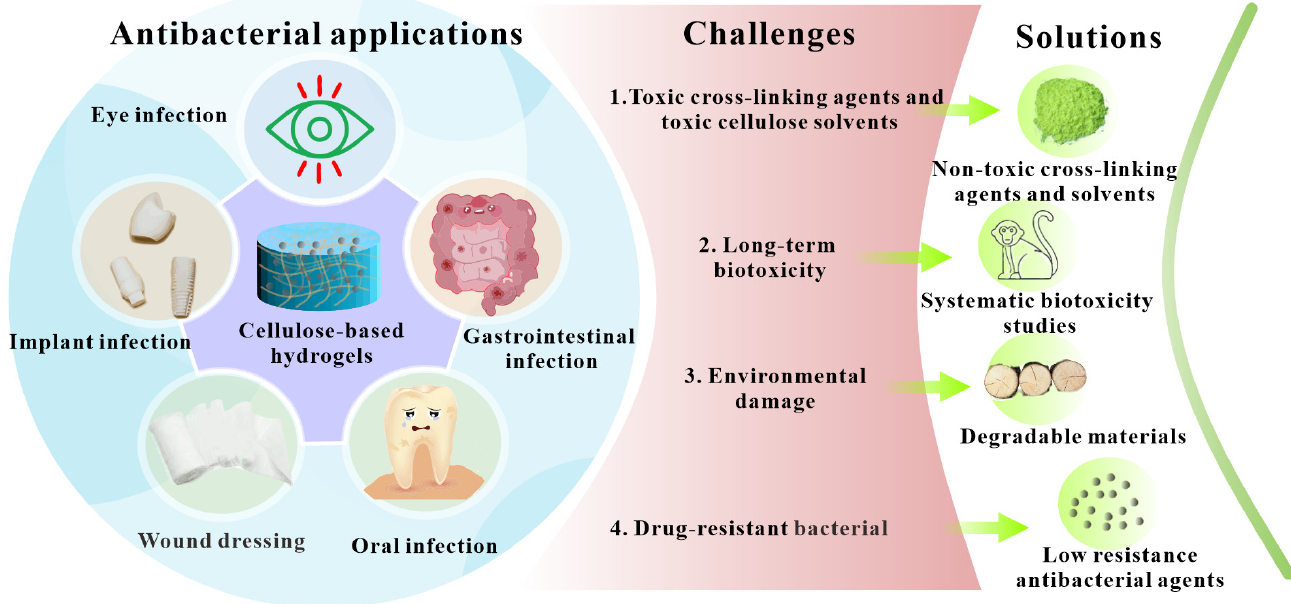
Figure 7. Challenges and solutions in antibacterial applications of cellulose-based hydrogels .